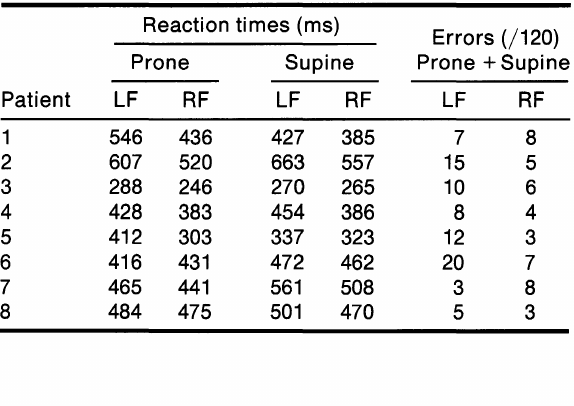
TABLE II. Patients' mean reaction times and combined errors for left (LF) and right (RF) fingers in prone and supine hand